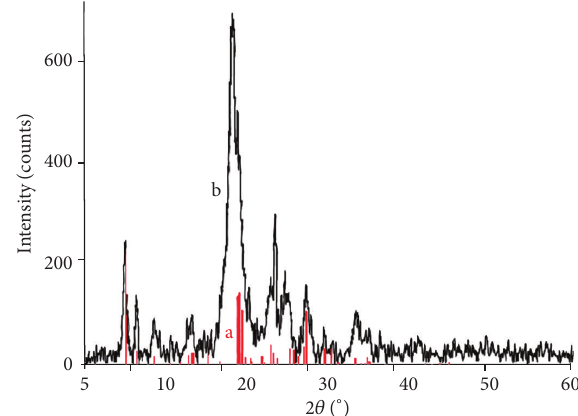
F 1: XRD patterns of (a) the reference pattern of clinoptilolite and (b) prepared zeolite